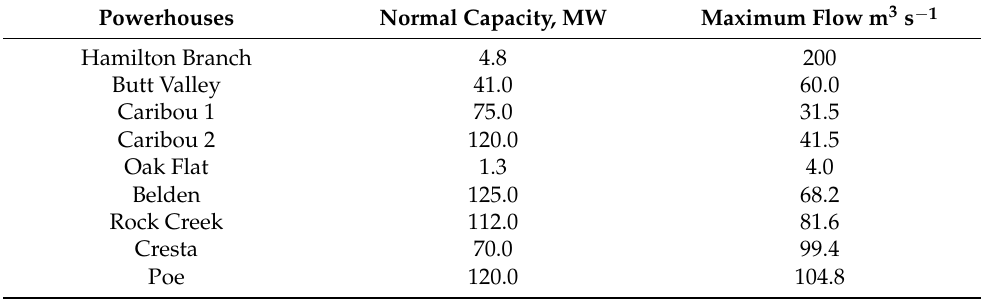
Table 2. The powerhouses.